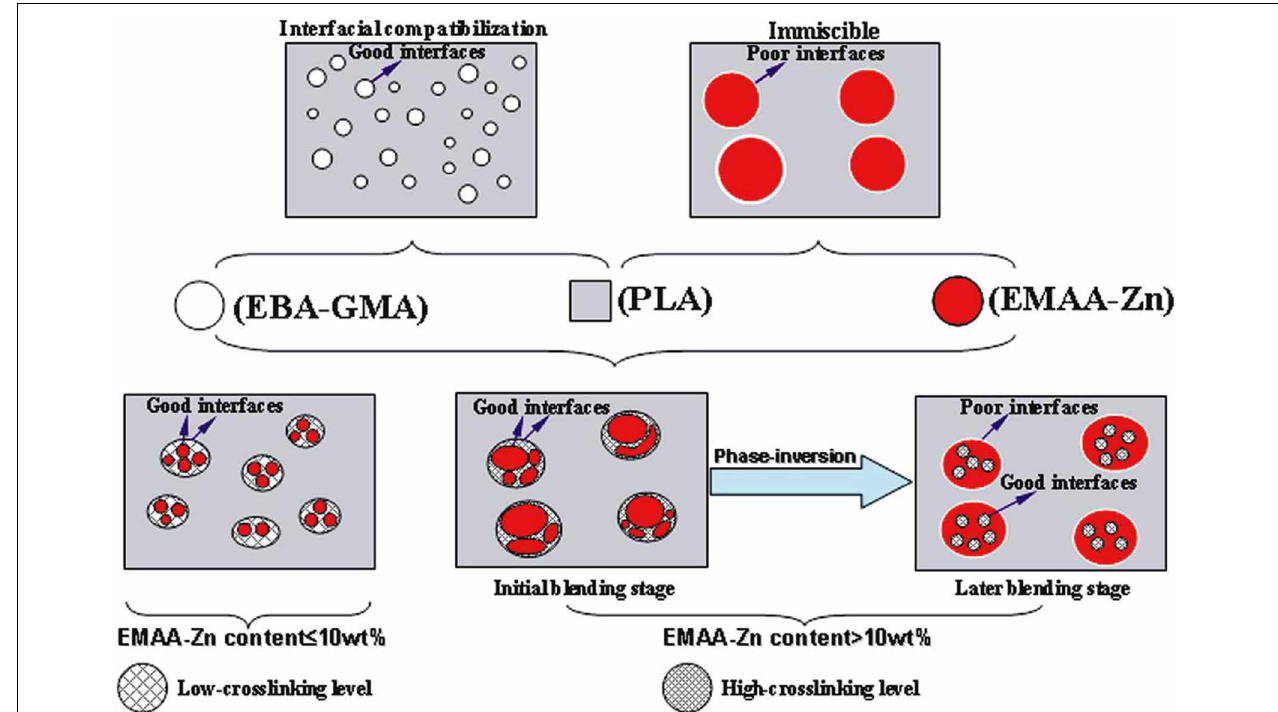
FIGURE 19 | Phase structure development for the studied PLA blend systems. Adapted with permission from Liu et al.